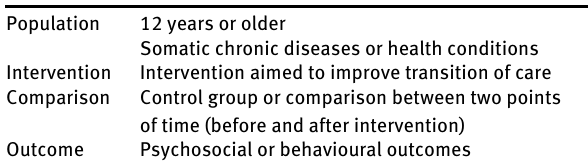
Table 1: PICO framework defining inclusion